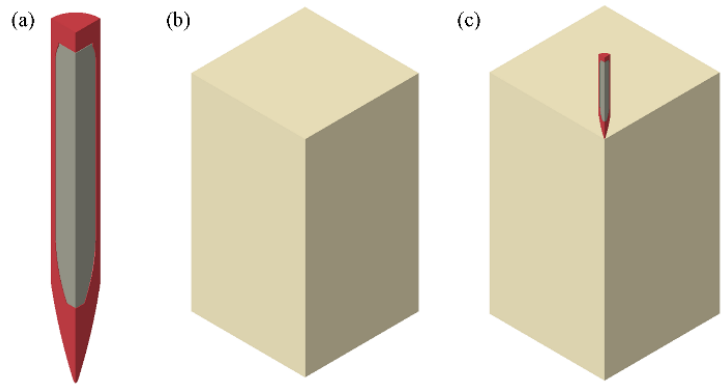
Figure 12. Finite element model of the penetration of an earth penetrating missile (EPM) with PBX1314 charge into a concrete target. ( a ) a missile (the red part) with PBX (the grey part), ( b ) a concrete target, ( c ) assembly of the missile and the target.